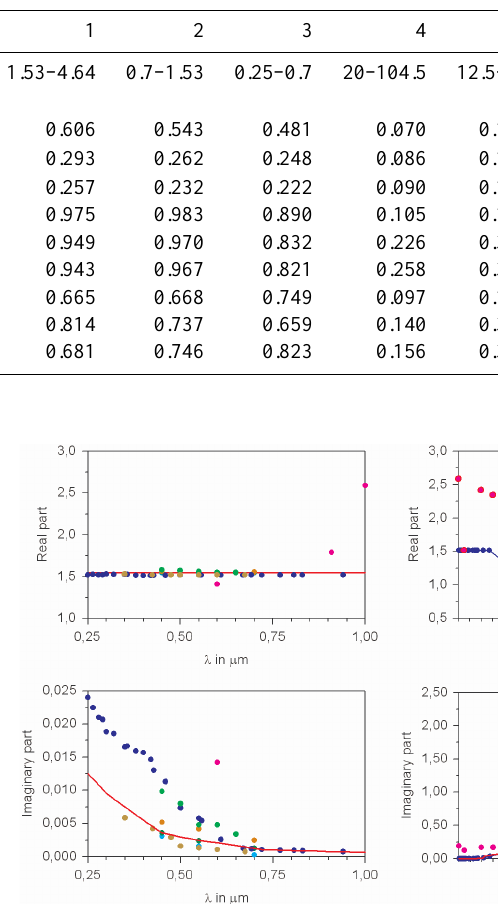
Table 3. Specific extinction coefficient ( ˜ b e ) , single scattering albedo ( ˜ ω) , and asymmetry parameter ( ˜ g) derived from Mie-calculations for the three dust modes (1–3) and the eight spectral bands ( k ) used by COSMO-ART. The values of the specific extinction coefficients are given in m 2 g − 1 .